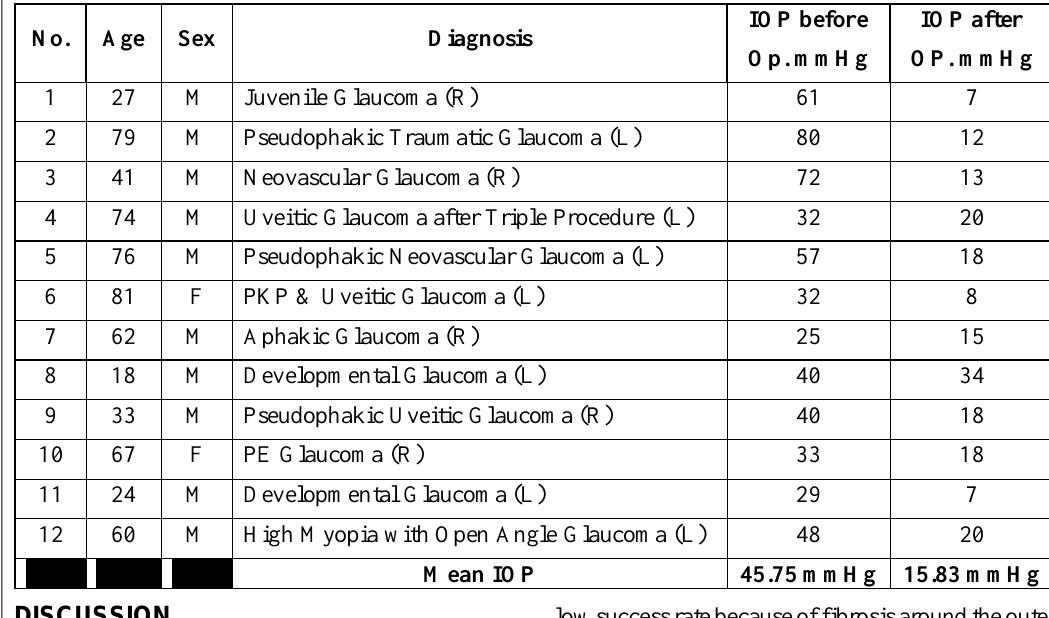
Table I : Silicone Tube Shunt